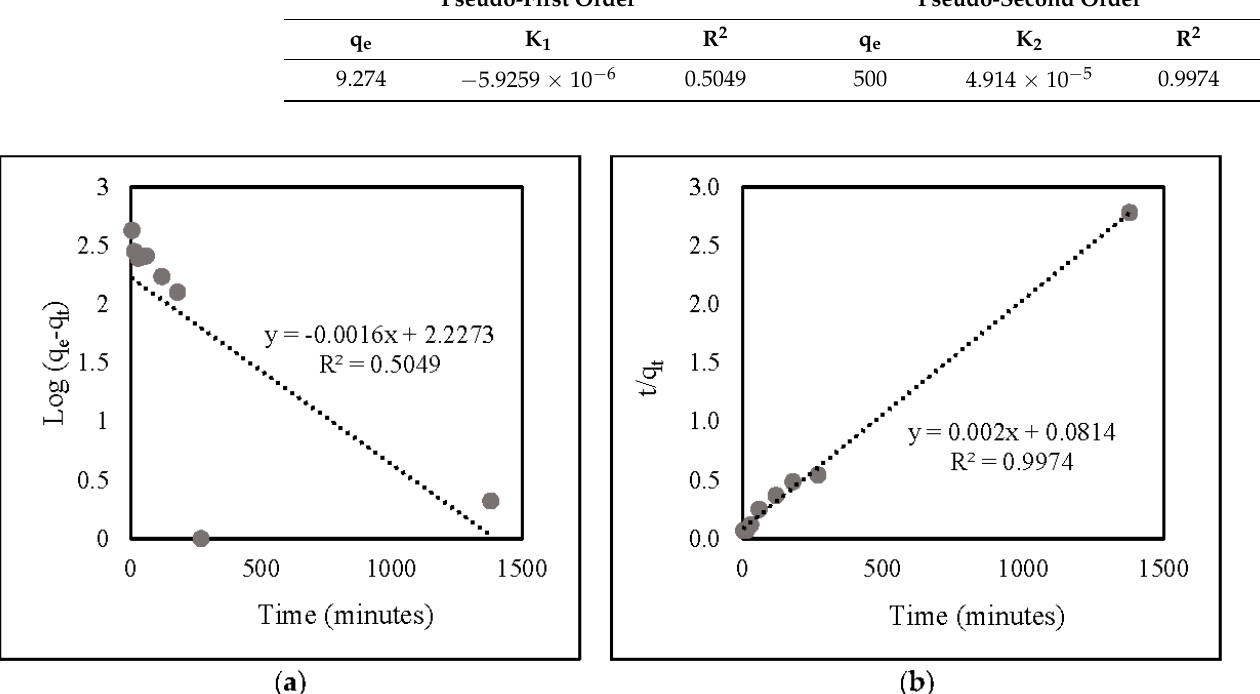
Figure 8. Linear kinetic plot of nitrate adsorption onto ZLCH-Fe: ( a ) pseudo-first-order model; ( b ) pseudo-second-order model.